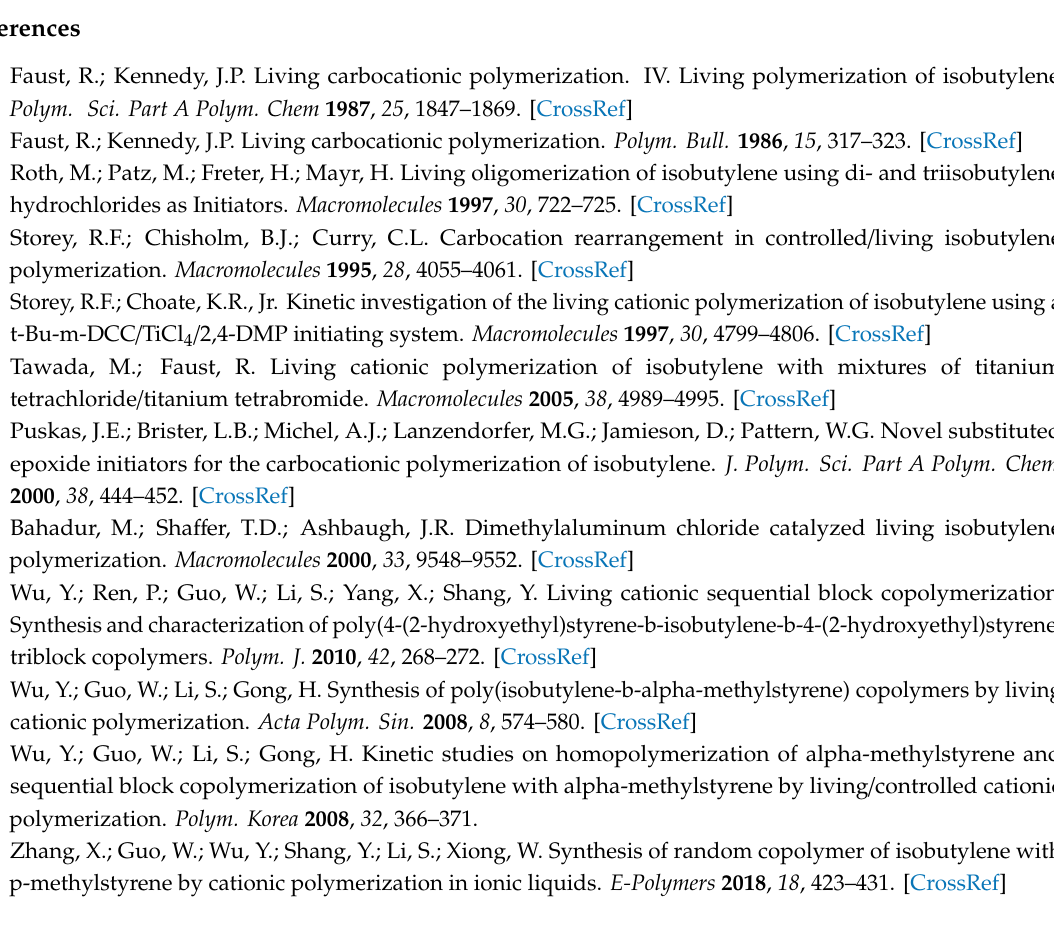
Figure S1: GPC traces of PIB initiated by TMPCl / DTBP / TiCl 4 system in cyclohexane / CH 3 Cl 60 / 40 ( v / v ) at − 80 ◦ C, [TMPCl] = 2.87 × 10 − 3 M, [DTBP] = 7.18 × 10 − 3 M, [TiCl 4 ] = 0.09 M, and [IB] = 1.01 M.; Figure S2: Mn and Mw / Mn as a function of conversion for the polymerization of IB initiated by TMPCl / DTBP / TiCl 4 system in cyclohexane / CH3Cl 60 / 40 ( v / v ) at − 80 ◦ C, [TMPCl] = 2.87 × 10 − 3 M, [DTBP] = 7.18 × 10 − 3 M, [TiCl 4 ] = 0.09 M and [IB] = 1.01M.; and Figure S3: First–order plot for the polymerization of IB initiated by TMPCl / DTBP / TiCl 4 system in cyclohexane / CH 3 Cl 60 / 40 ( v / v ) at − 80 ◦ C, [TMPCl] = 2.87 × 10 − 3 M, [DTBP] = 7.18 × 10 − 3 M, [TiCl 4 ] = 0.09 M and [IB] = 1.01